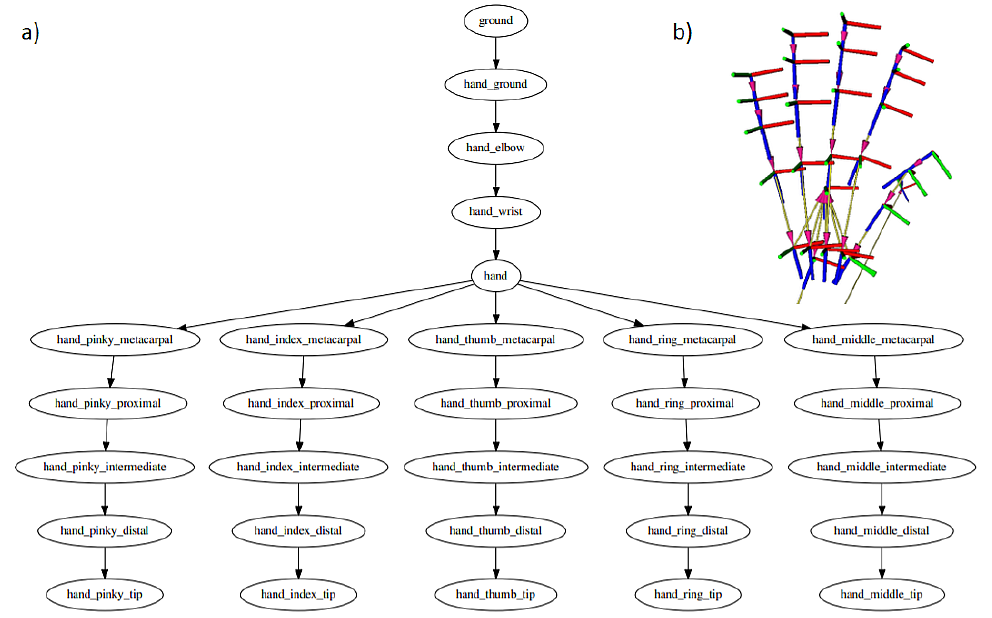
Figure 3. ( a ) Joint connections scheme distributed in the ROS system, ( b ) visualization of bones positions and orientation quaternions of the hand and wrist using ROS